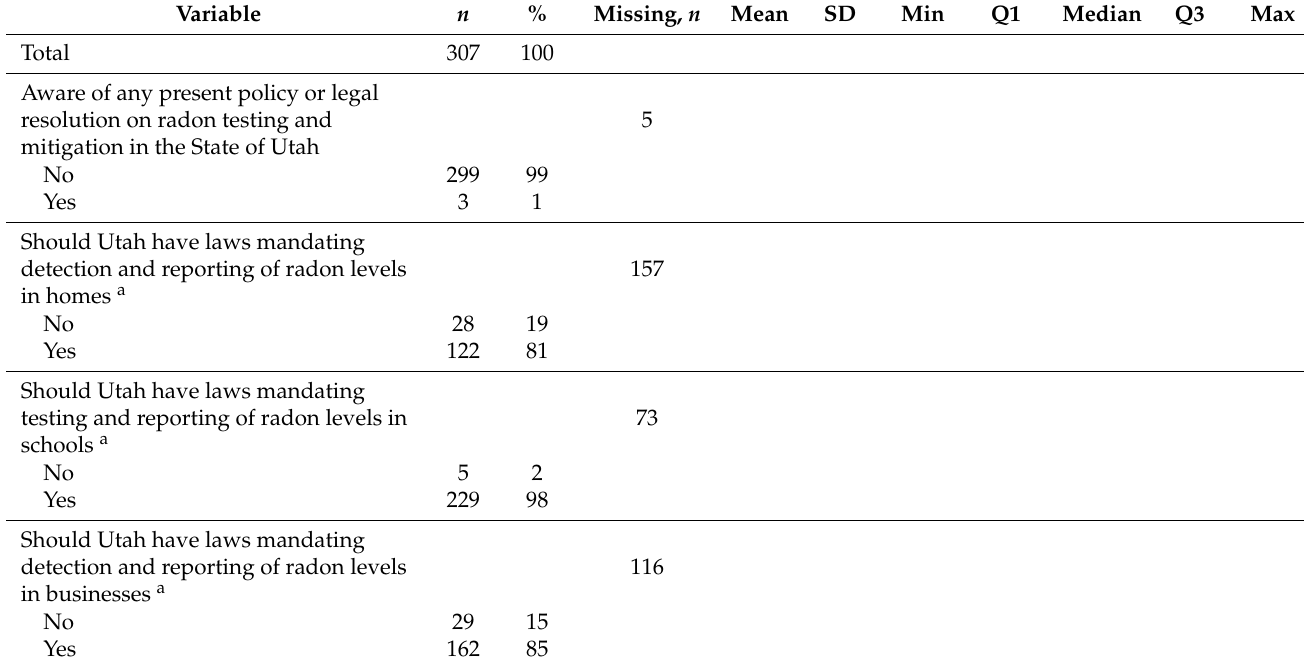
Table 2. Awareness and opinions of radon policies among radon testing survey participants, Utah County, Utah, May 2014–January